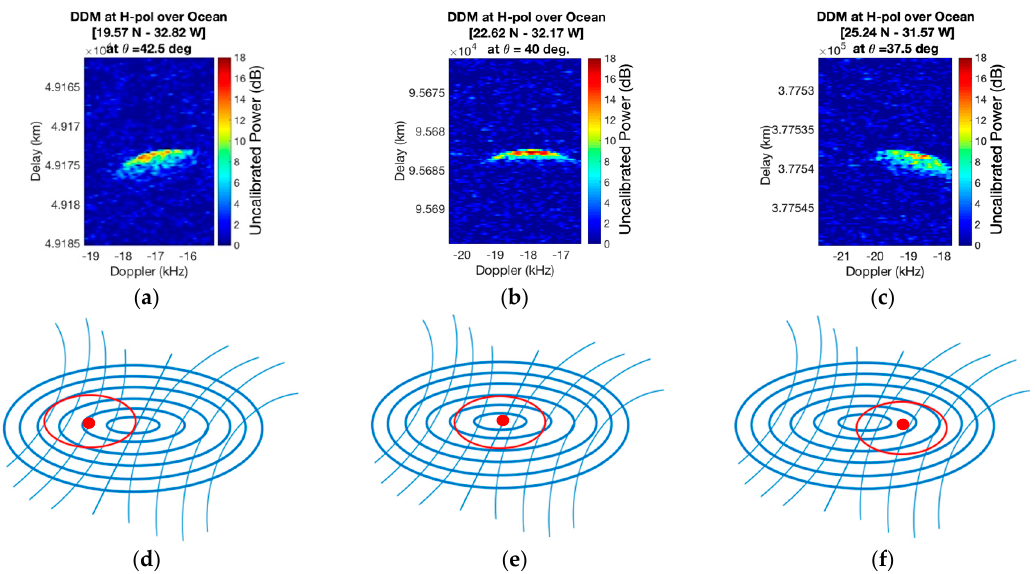
Figure 11. Top: Delay-Doppler Maps of the scattered power measured by SMAP-R for an ocean surface for ( a ) 42.5 ◦ , ( b ) 40 ◦ , and ( c ) 37.5 ◦ incidence angles. Bottom: iso-delay (blue ellipses) and iso-Doppler lines (blue hyperbolae) computed from actual SMAP-R and GPS geometries and velocities with the antenna beam pattern (red) over-imposed to those isolines for the same ( d ) 42.5 ◦ , ( e ) 40 ◦ , and ( f ) 37.5 ◦ incidence angles. Note that these are not to scale: The scattering area represents 200 km major axis ellipse, while antenna beam pattern diameter is represented by the − 3 dB beamwidth, i.e., 40 km. The antenna boresight is shown as a red dot.